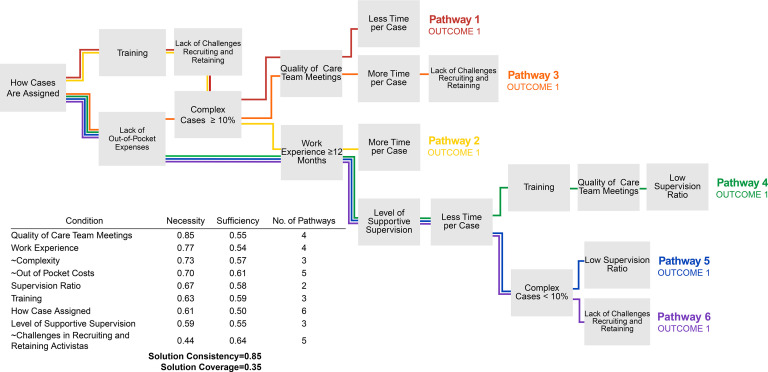
Outcome 1: Percentage Change in HIV Status Knowledge in Orphans or Vulnerable Children in MozambiqueNote: The numbering of the pathways is random; each pathway demonstrates an alternative combination of conditions that positively influenced the outcome and is considered to be equally sufficient in achieving the outcome.